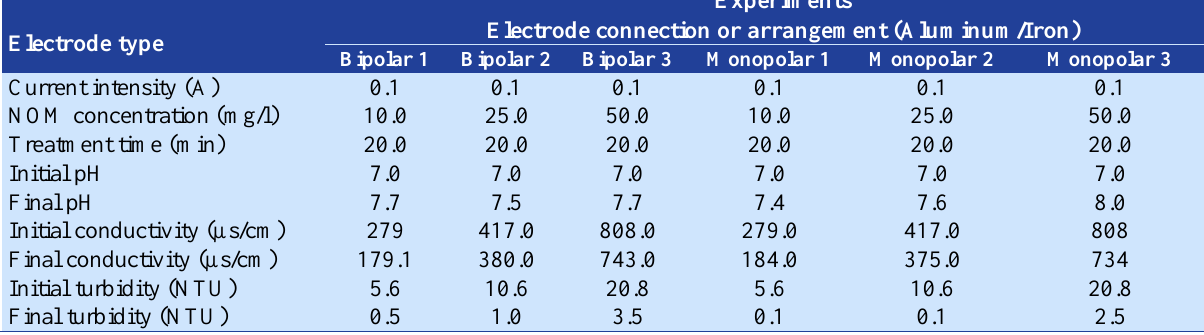
Figure 7. Natural organic matter (NOM) removal efficiencies for both bipolar and monopolar electrodes connection at optimum condition (pH = 7, current = 0.1 A, and reaction time = 20 min) Table 1. Changes in turbidity, conductivity and pH optimum conditions for bipolar and monopolar